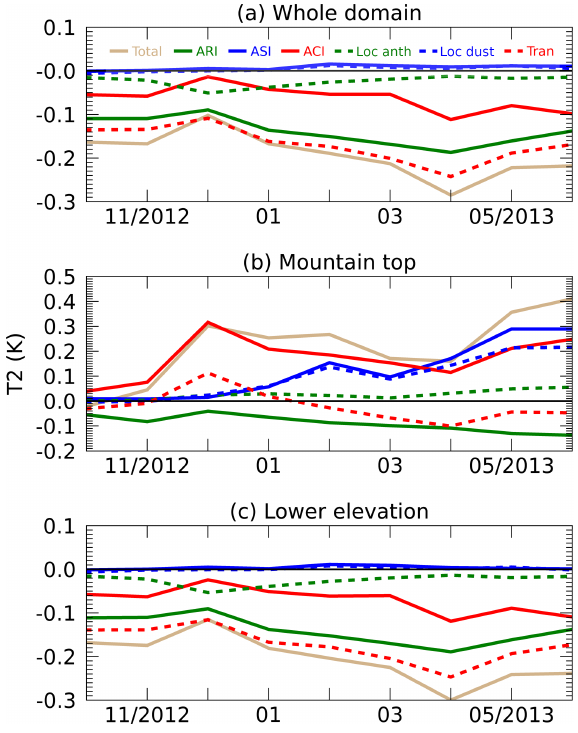
Figure 16. Same as Fig. 14, but for T2 (K).